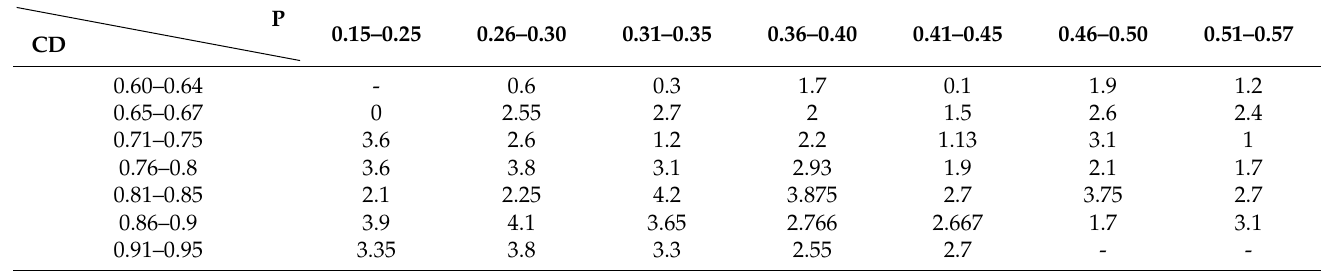
Table 4. Mean values of the regression model of canopy density, porosity, and cooling volume.